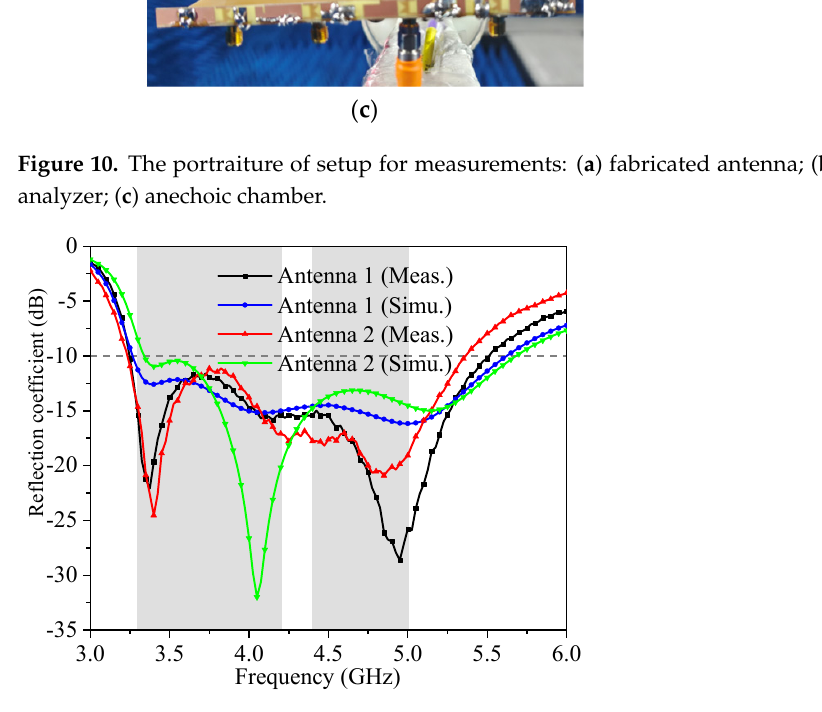
Figure 11. The measurement and simulation results of the reflection coefficients of the antenna.